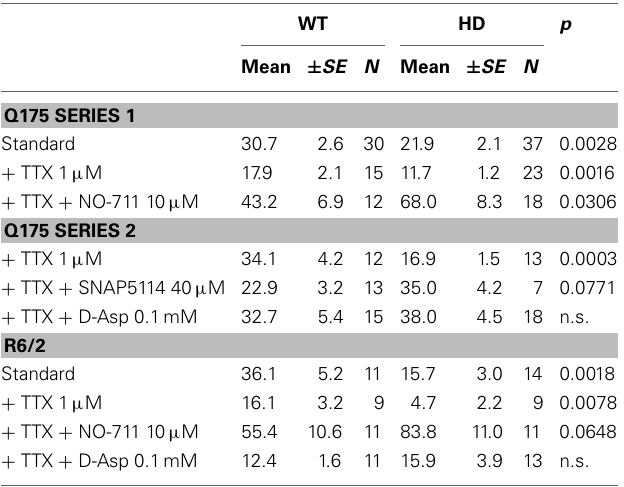
Table 1 | Characteristics of I ( Tonic ) GABA in two mouse models of HD. WT HD p